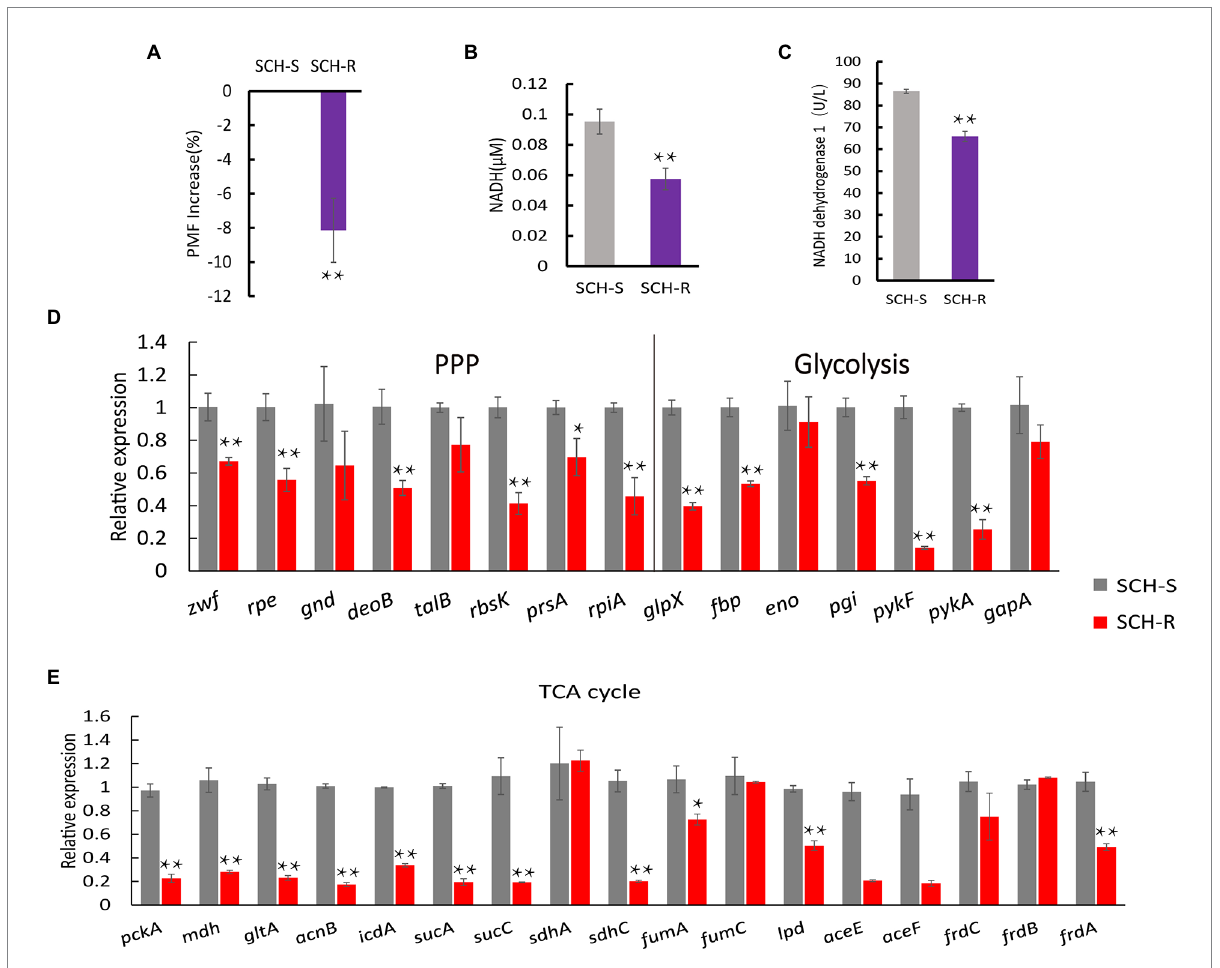
FIGURE 3 SCH-R resistance is mediated by disrupted central carbon metabolism. (A) Variation of the PMF in SCH-R and SCH-S. (B) NADH concentration in SCH-R and SCH-S. (C) Activity of NADH dehydrogenase 1 in SCH-R and SCH-S. (D,E) QRT-PCR for the expression of key genes in central carbon metabolism. pckA , phosphoenolpyruvate carboxykinase; mdh , malate dehydrogenase; gltA , citrate synthase; acnB , aconitate hydratase 2; icdA , isocitrate dehydrogenase; sucA , 2-oxoglutarate dehydrogenase E1 component; sucC , succinyl-CoA synthetase beta subunit; sdhA , succinate dehydrogenase; sdhC , succinate dehydrogenase; fumA , fumarate hydratase, class I; fumC , fumarate hydratase, class II; lpd , dihydrolipoyl dehydrogenase; aceE , pyruvate dehydrogenase E1 component; aceF , pyruvate dehydrogenase E2 component; frdC , fumarate reductase subunit C; frdB , fumarate reductase iron–sulfur subunit; frdA , fumarate reductase flavoprotein subunit; zwf , glucose-6-phosphate dehydrogenase; rpe , ribulose-phosphate 3-epimerase; gnd , 6-phosphogluconate dehydrogenase; deoB , phosphopentomutase; talB , transaldolase; rbsK , ribokinase; prsA , ribose-phosphate pyrophosphokinase; rpiA , ribose 5-phosphate isomerase A; glpX , fructose-1,6-bisphosphatase II; fbp , fructose-1,6- bisphosphatase I; eno , phosphopyruvate hydratase; pgi , glucose-6-phosphate isomerase; pykF , pyruvate kinase; pykA , pyruvate kinase; gapA